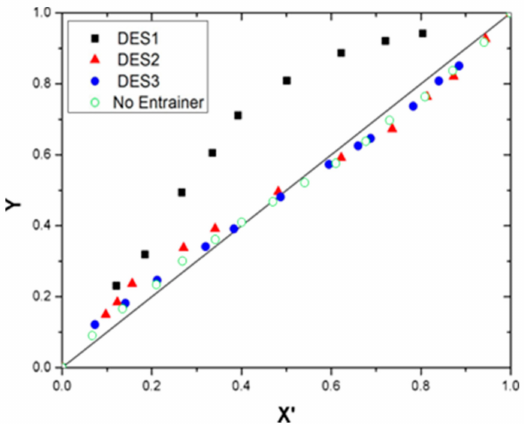
Figure 7. Experimental data for the pseudo-ternary systems ( a ) Benzene + cyclohexane + DES1;